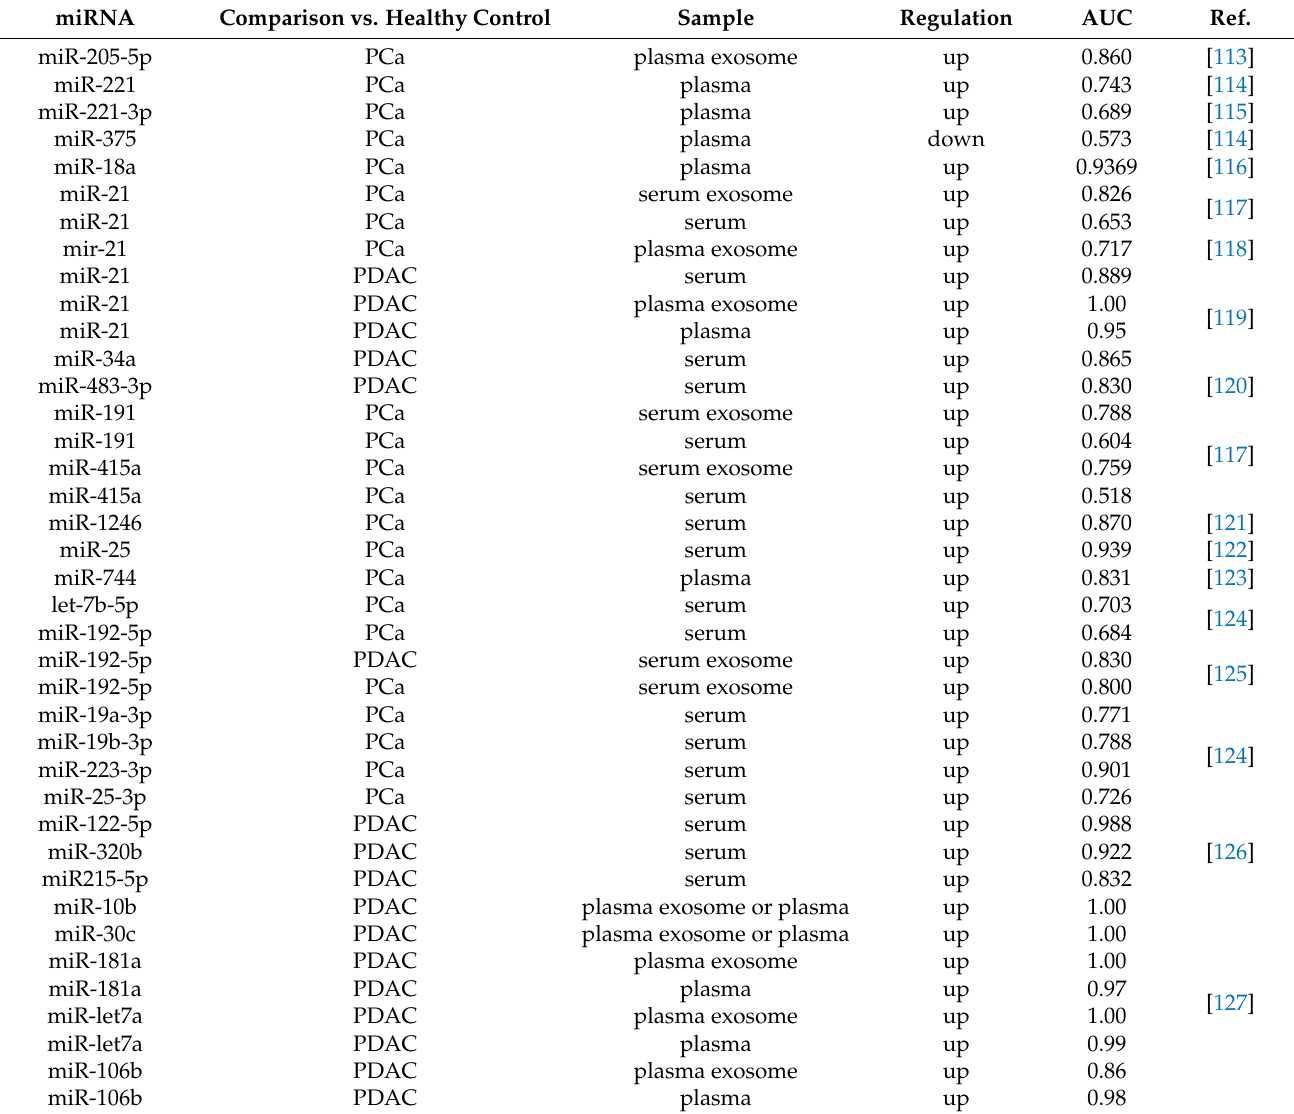
Table 1. Summary of promising microRNAs for diagnosis of pancreatic cancer. Comparison vs. Healthy